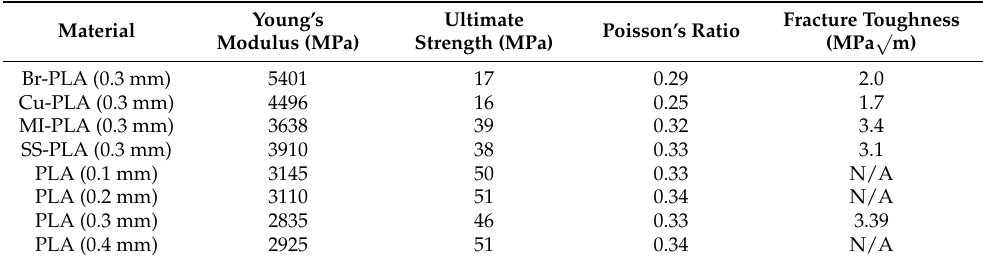
Table 4. Average Young’s modulus (MPa), ultimate strength (MPa), Poisson’s ratio, and fracture √ toughness (MPa m) for all materials used in this